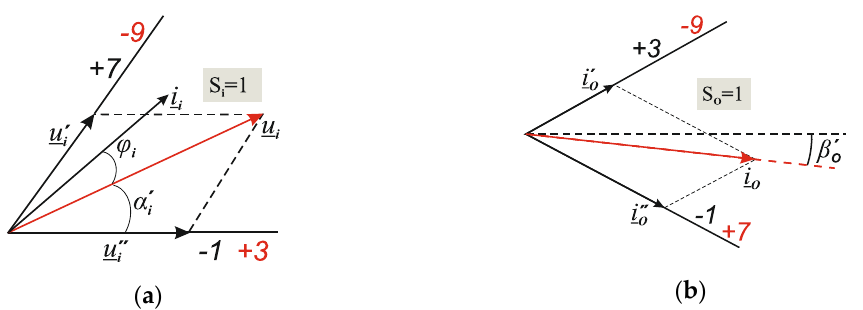
Figure 4. Graphic interpretation of active vectors: ( a ) input voltage at converter; ( b ) output current.